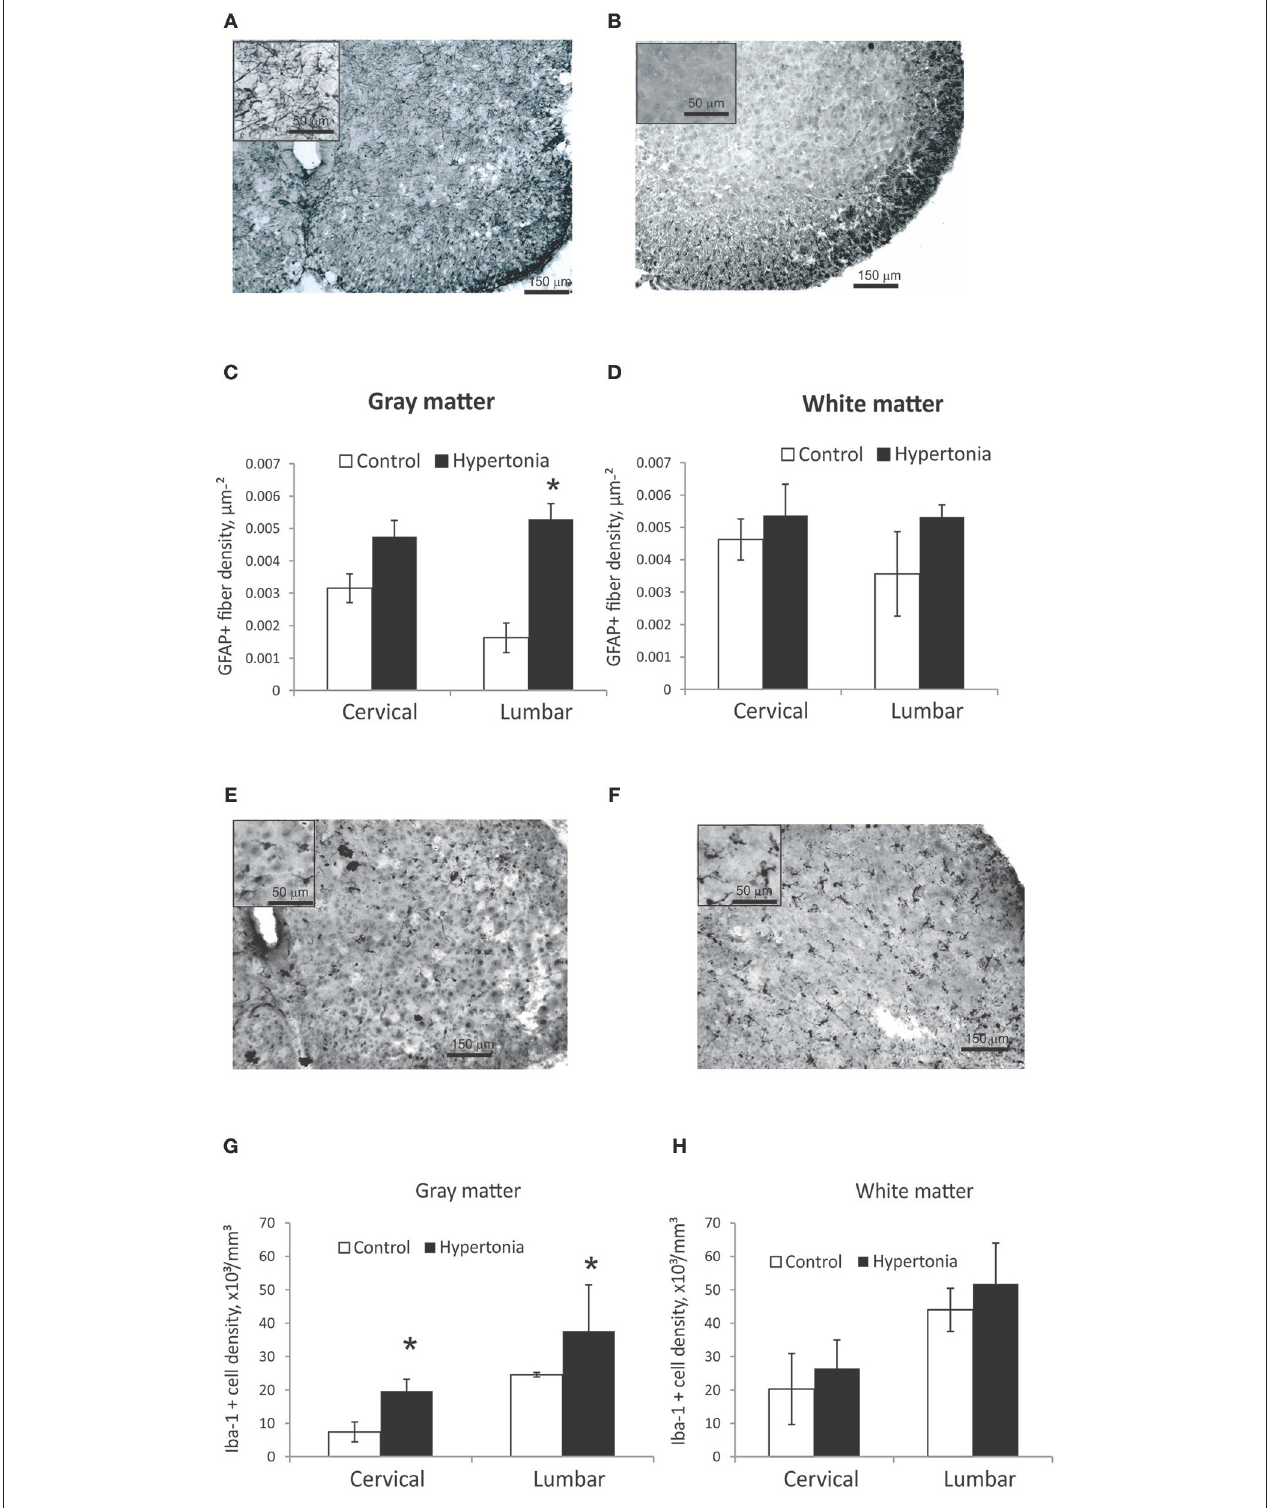
FIGURE 8 | Astrogliosis and increased density of microglia in spinal cord gray matter after antenatal H-I injury. (A,B) Representative GFAP staining in cervical cord of control (A) and hypertonic (B) kits. Inserts on top left corners show glial fibers at higher magnification. Significant increase in glial fiber density in gray matter (C) , but not in white matter (D) found on stereological quantification of GFAP positive fiber length. (E,F) Representative Iba-1 staining in cervical cord of control (E) and